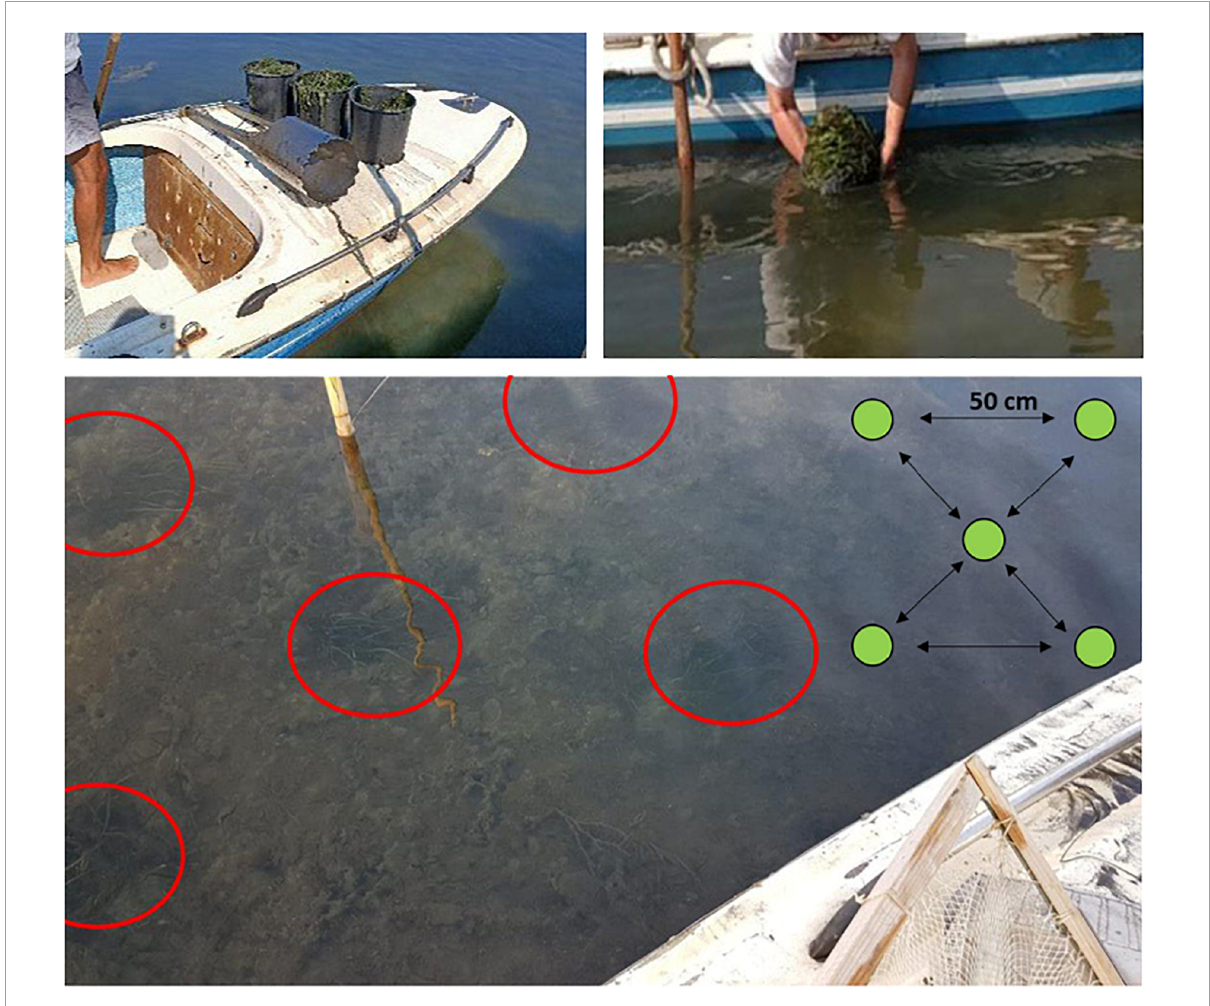
FIGURE7 Aquatic angiosperm transplantation (top) . Scheme of transplantation (bottom) .